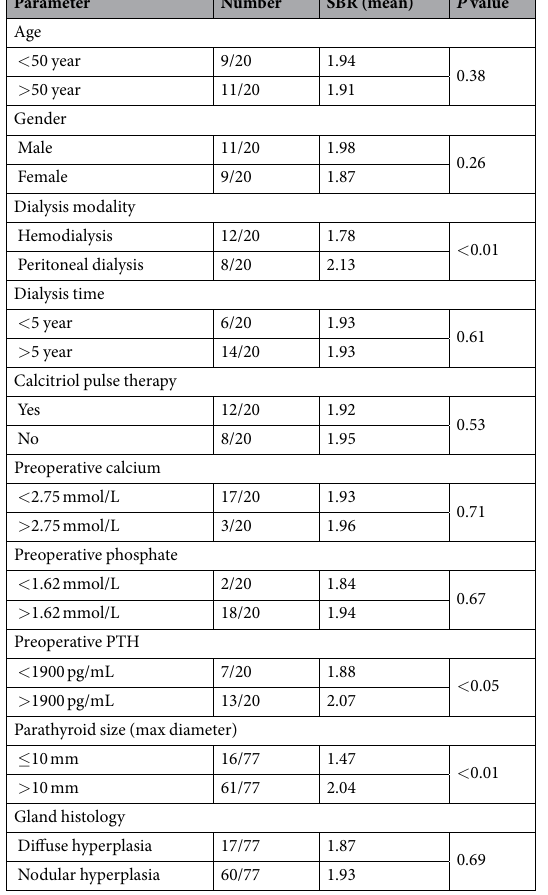
Table 1. Analysis of parathyroid fluorescence by clinical and histopathologic